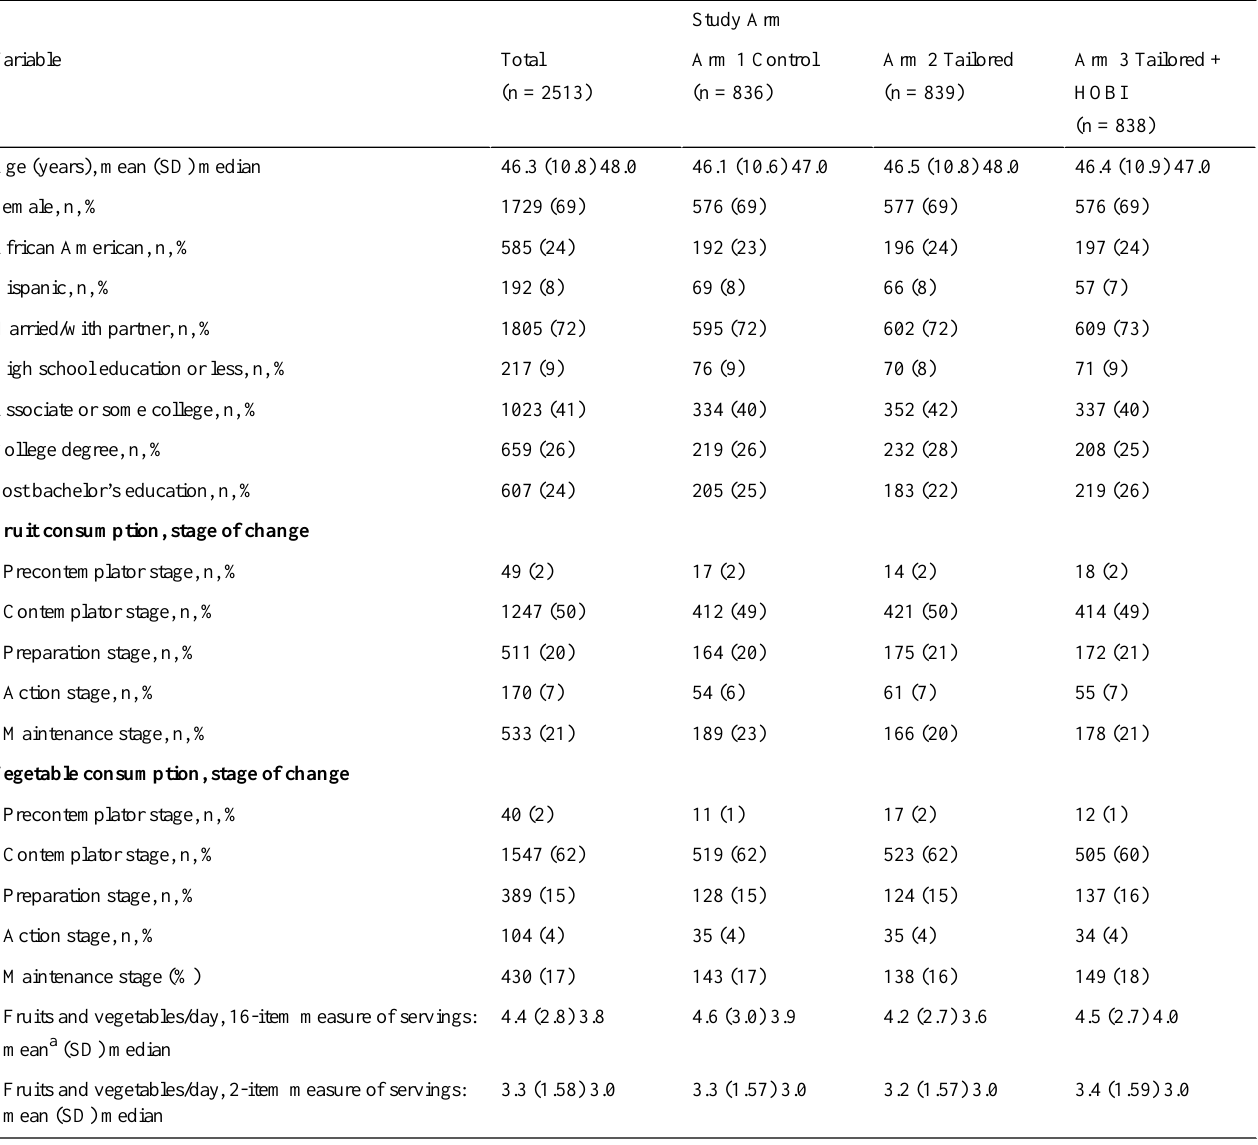
Table 1. Baseline description of the enrolled subjects by study